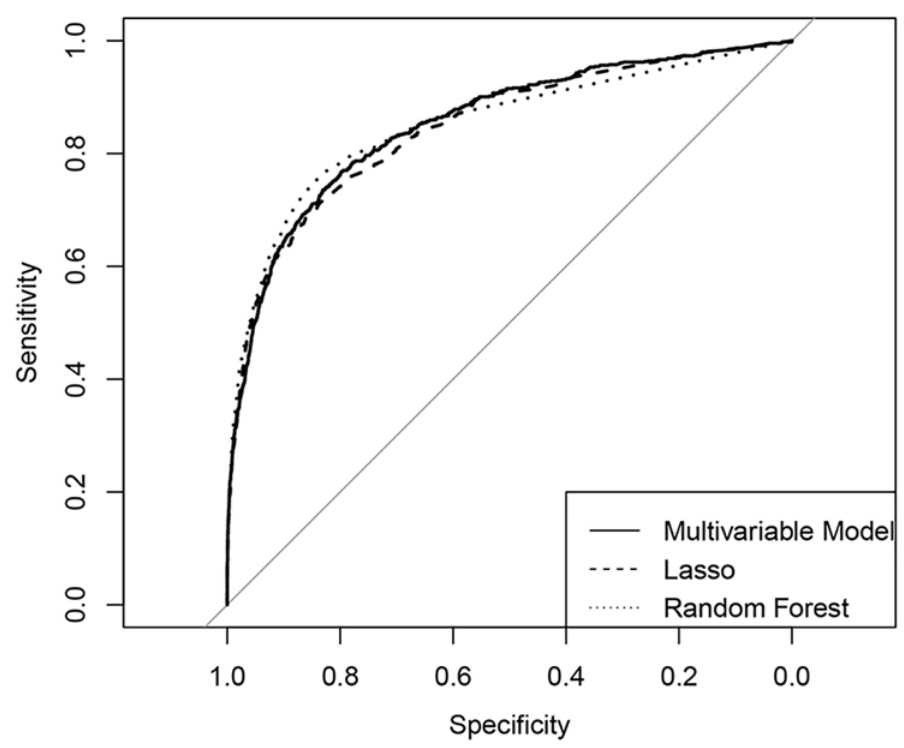
Fig 2. ROC-curves for the multivariate regression model and the two variable selection methods for the prediction of deficit outliers (outlier selection with IQR method) (n = 8,892, test set).